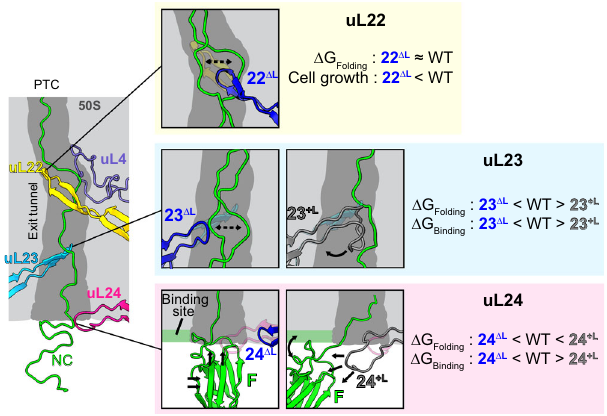
Fig. 6 The impact of the tunnel loop modi fi cations on the ribosome-NC interactions and co-translational folding. Schematic illustration and the summary of the impact of loop modi fi cations on the dynamics and folding of FLN5 NC. Δ G Folding and Δ G Binding denote the free energy of folding and free energy of binding of the U state,